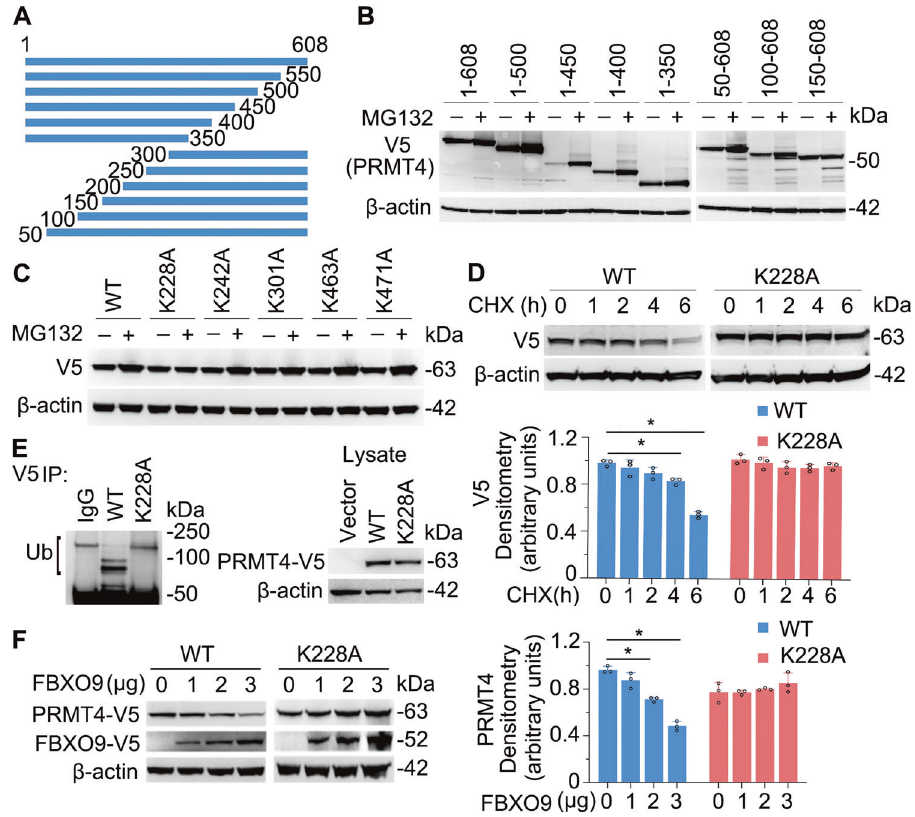
Fig. 4 SCF FBXO9 ubiquitinates PRMT4 at K228. A Schematic presentation of PRMT4 truncation constructs that were expressed in BEAS-2B cells. B Fragment 150 – 608 does not accumulate after MG132 treatment. C Cellular expression of a K228A point mutant does not accumulate after MG132 treatment. D Cellular expression of a K228 mutant of PRMT4 is stable after CHX treatment. E Cellular expression of a V5-PRMT4 K228A mutant vs. a V5 wild-type (WT) PRMT4 is not ubiquitinated. Constructs were expressed in cells and immunoprecipitated using V5 antibodies and probed with ubiquitin antibodies. The right blot shows the levels of WT and mutant construct protein expression in cells. F Ectopic expression of FBXO9 does not degrade the PRMT4 K228A mutant. * P < 0.05 vs. “ 0. ” Experiments n =